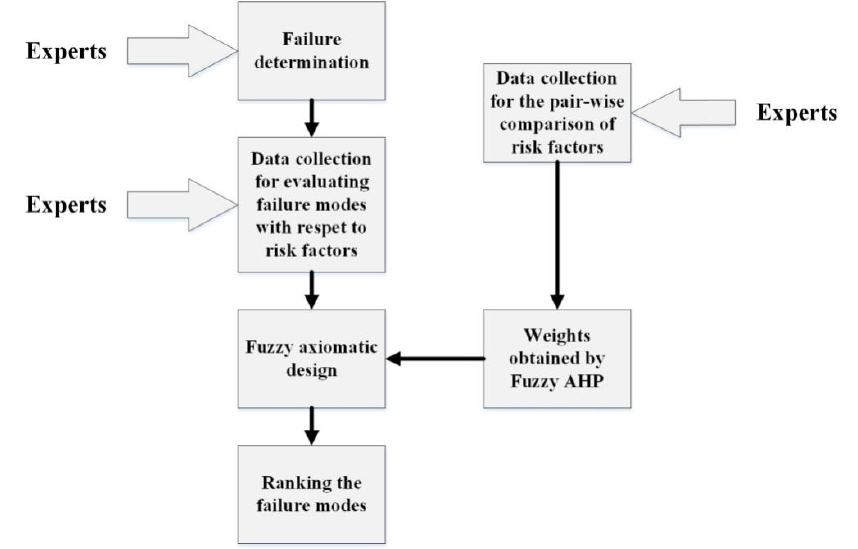
Figure 9. Flowchart of the proposed